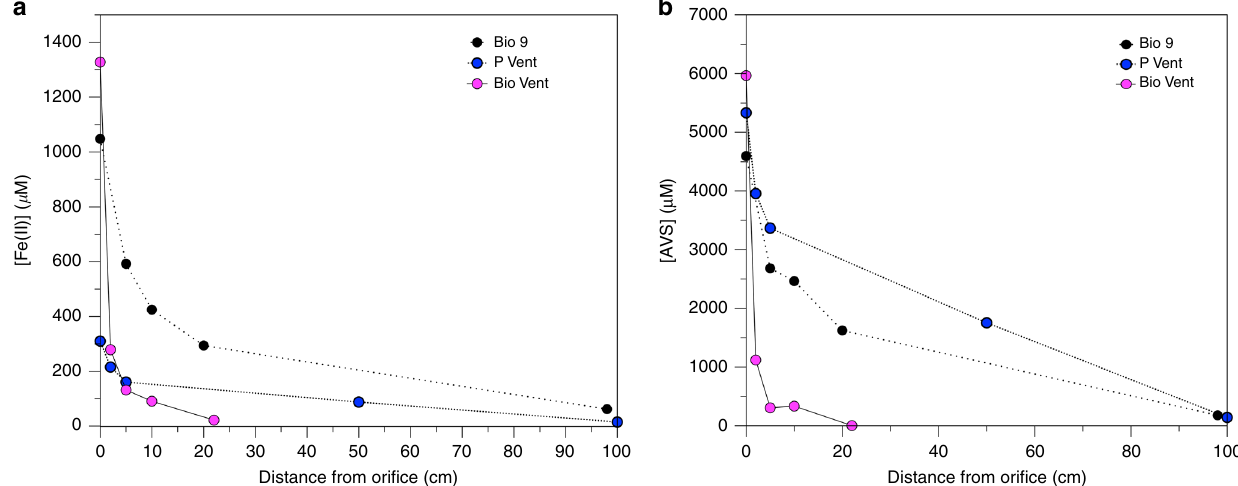
Fig. 1 Plume iron and sulphur geochemistry. a Total un fi ltered Fe(II) concentrations in all three plumes and b Total un fi ltered AVS concentrations in all three